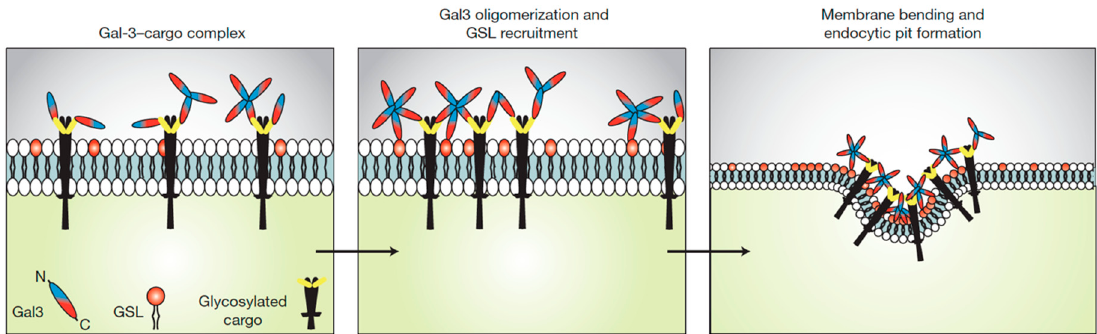
Figure 1. Endocytic pit construction according to the GL–Lect hypothesis. The sugar binding protein galectin-3 (Gal3) is monomeric in solution. It binds to complex carbohydrates of plasma membrane glycoproteins (glycosylated cargo). This leads to Gal3 oligomerization, thereby enabling its capacity to interact with glycosphingolipids (GSLs) in a way such as to induce narrow membrane bending and the clathrin-independent formation of endocytic pits into which the glycosylated cargoes are recruited. From these pit, endocytic carriers are then generated for the cellular uptake of the glycosylated cargoes (not shown). Reproduced with permission from Ref.